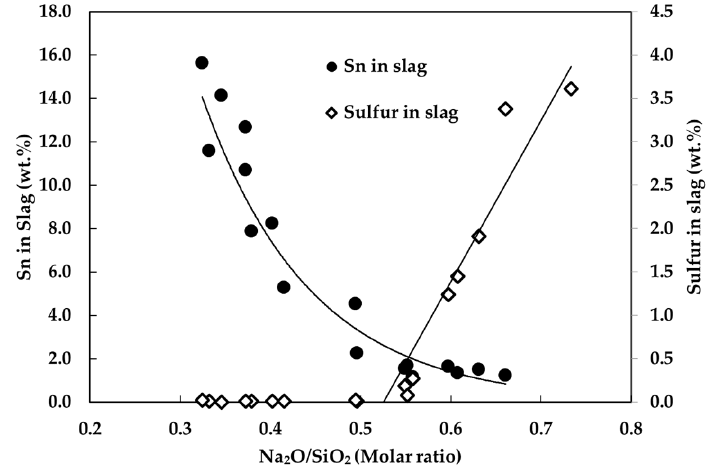
Figure 4. Effect of Na 2 O/SiO 2 molar ratio on the residual tin and sulfur cosntent in slag (1200 °C, 2 h).